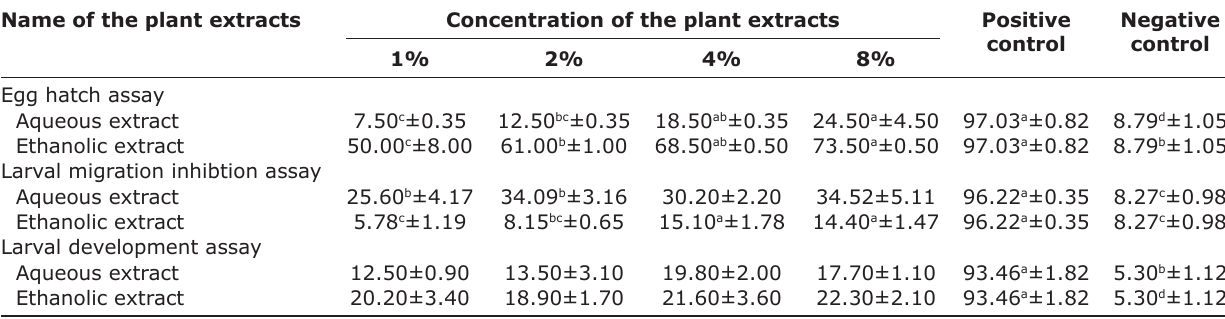
Table-1: Mean percent efficacy of aqueous and ethanolic extracts of I. tinctoriaon nematode egg hatch, larval migration and larval development inhibition. Name of the plant